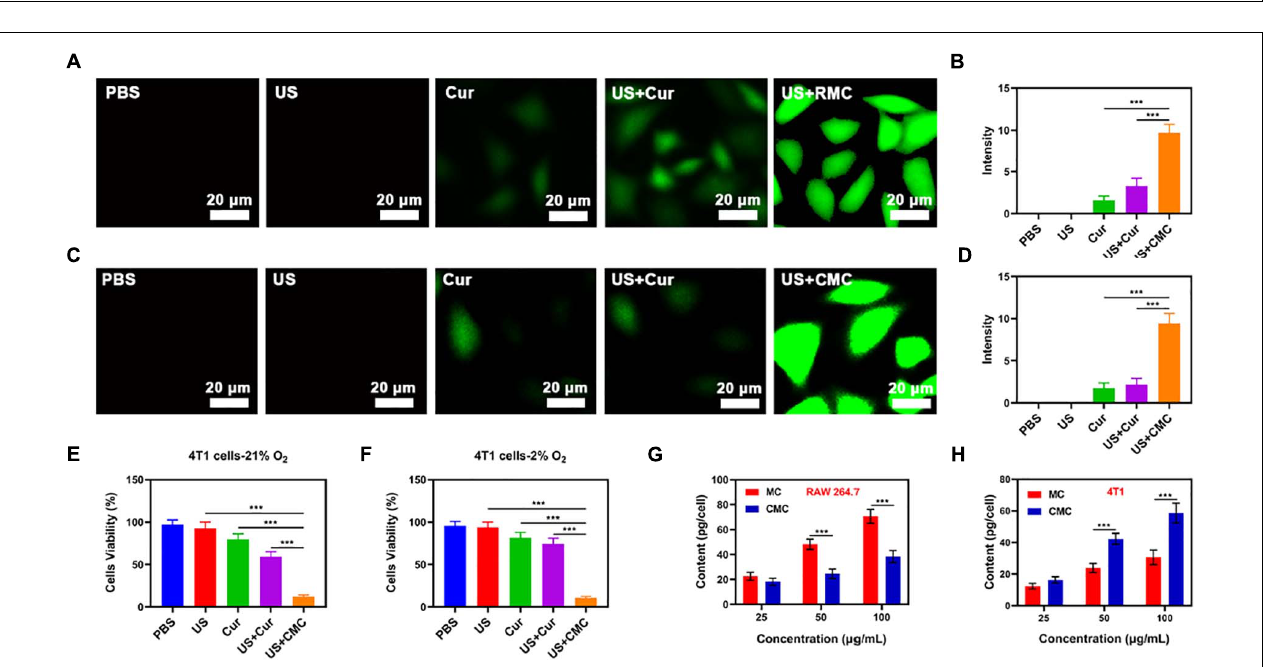
FIGURE 1 | Characterization of CMC. (A) TEM images of (i) MC and (ii) CMC. (B) Zeta potential and (C) Hydrodynamic diameter of MnO 2 NPs, MC, CV and CMC. (D) Coomassie-stained SDS-PA gel image showing the protein composition of CV, CMC and MC. (E) Absorbance spectrum of Curcumin, MC and MnO 2 .